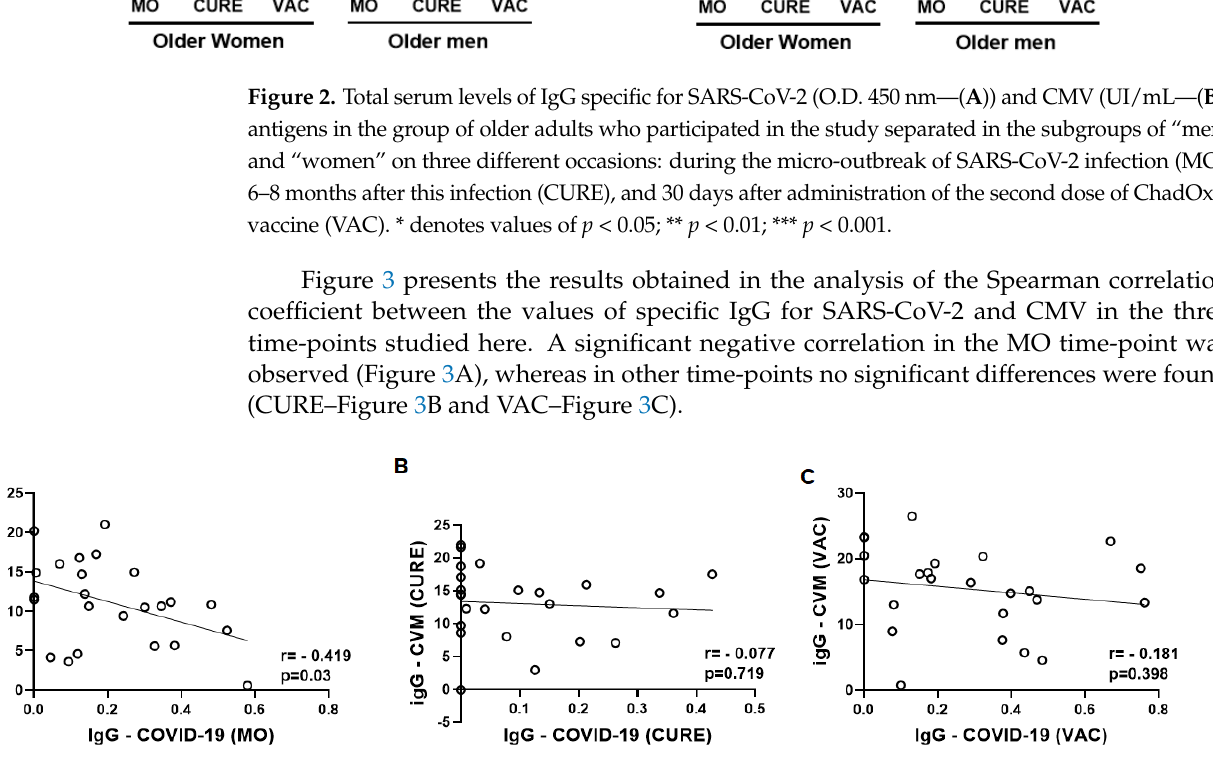
Figure 2. Total serum levels of IgG specific for SARS-CoV-2 (O.D. 450 nm — A ) and CMV (UI/mL —